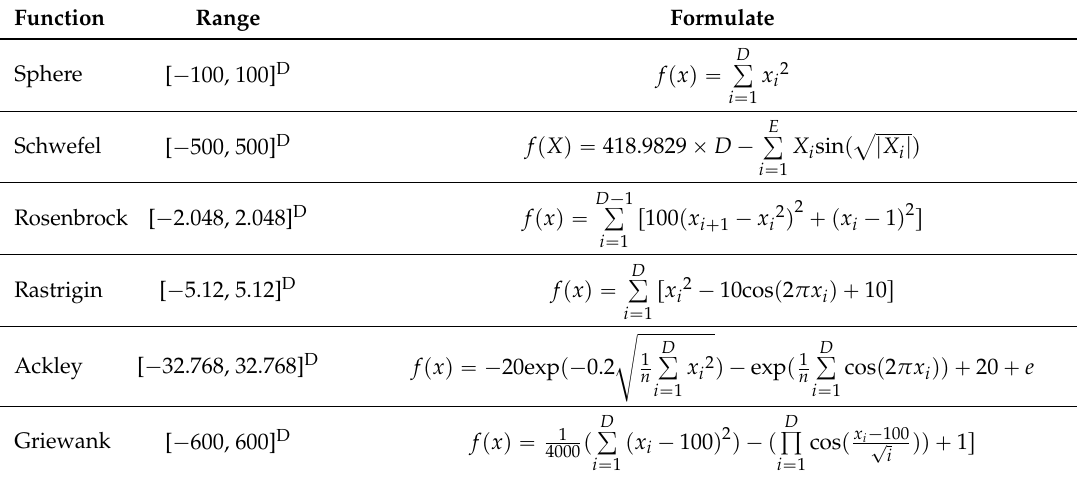
Table 1. Expression of six test